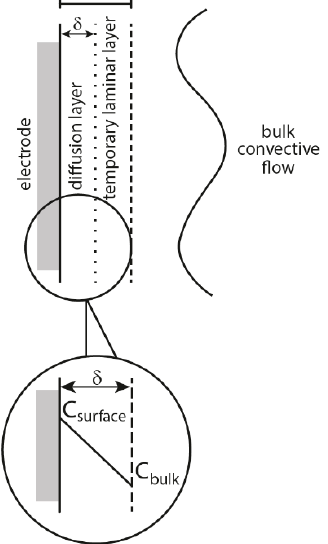
Figure 1. Schematic representation of the diffusion and boundary layers at the electrode-solution interface as applied in the diffusion layer model. Reprinted from [20] by permission of John Wiley & Sons, Inc.